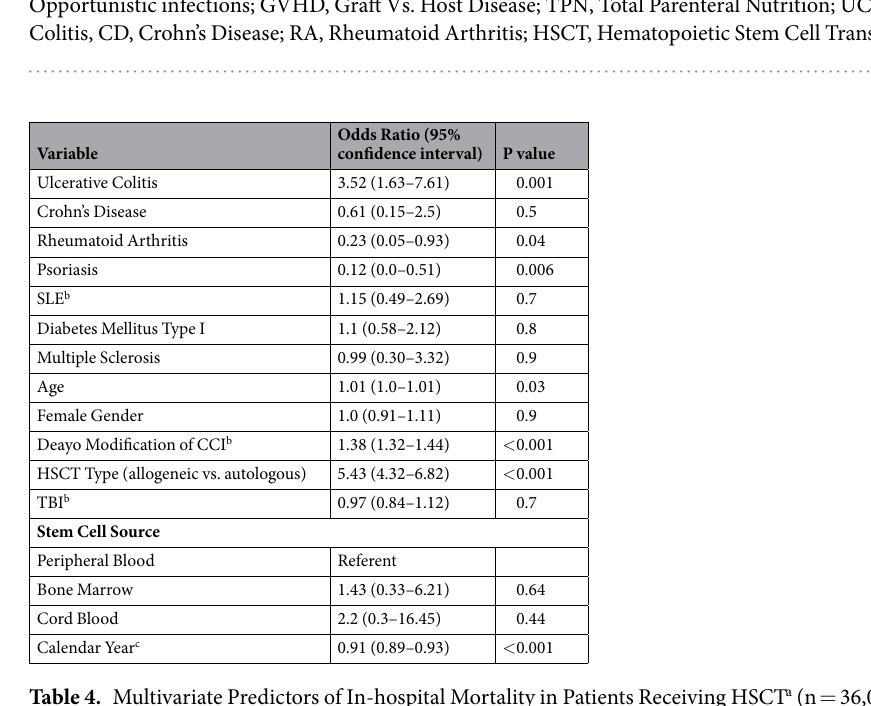
like bacteremia (10.9% vs. 23.6%, P = 0.06), OI (10.9% vs. 23.6%, P = 0.16) and febrile neutropenia (FN) (33.6% vs. 29.4%, P = 0.52) (Table 2). Length of stay and total charges were lower as compared to no IMIDs. Outcomes of HSCT in Psoriasis. The psoriasis cohort consisted of 99 patients, out of which 37 underwent allogeneic HSCT and 62 underwent autologous HSCT. Baseline characteristics are detailed in Tables 1, 2 and Supplementary Table S1. Psoriasis was associated with reduced mortality (odds ratio, 0.12; 95% confidence inter- val, 0.0–0.51; P = 0.006) which was consistent with the more stringent matched-pair analysis (Tables 3 and 4). In multivariate analysis, psoriasis patients had significantly lower rates of bacteremia (10.2% vs. 19.2%, P = 0.009) and intubation (0% vs. 4.2%, P < 0.001) as compared to patients without IMIDs (Table 1), which was consistent